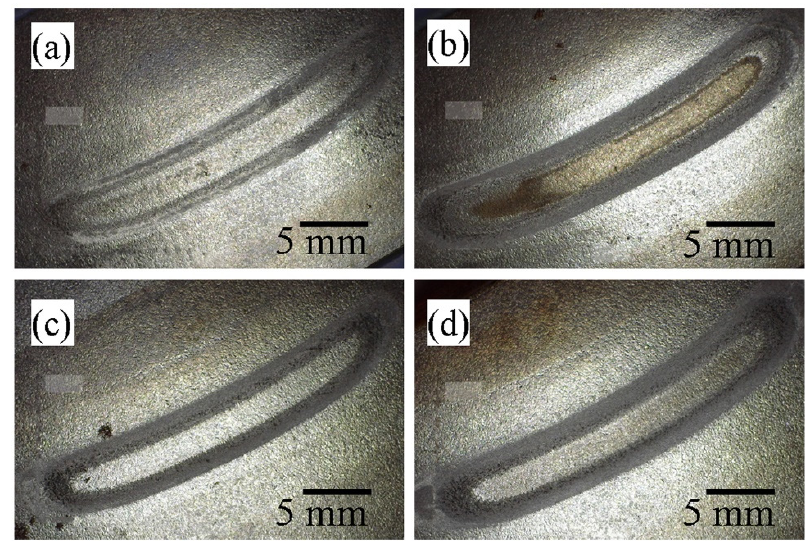
Figure 10. Ring-shaped annular elliptical weld profiles obtained with an O-shaped flat coil. Annular grey region indicates the fracture surface after complete separation of the flyer and target sheets during peel testing. Process conditions: applied energy ( a ) 10, ( b , c ) 13, and ( d ) 16 kJ, standoff distance ( a , b ) 1.2 and ( c , d ) 2.4 mm, and flyer sheet—AA5182, target sheet—DC04 steel.